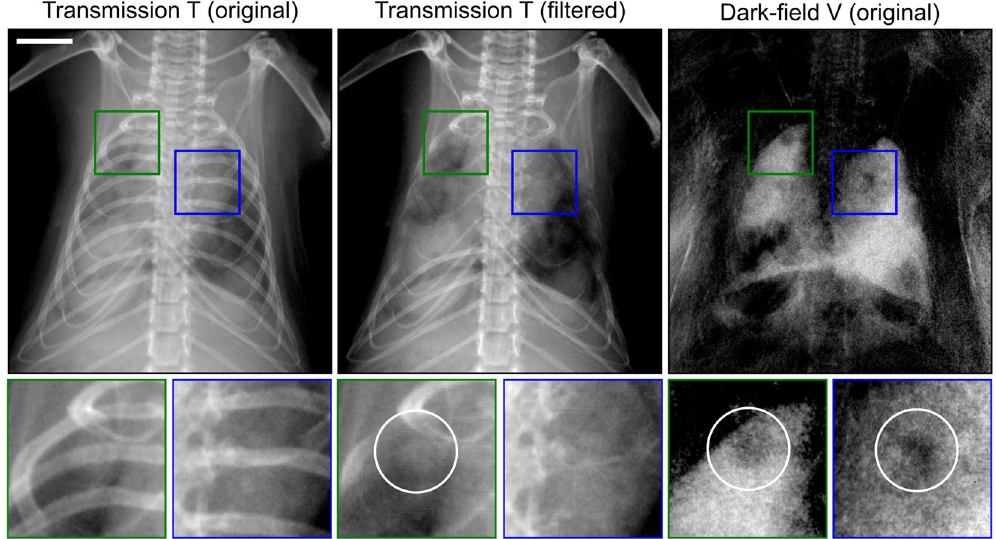
Figure 5. Outlook: initial comparison of ribcage-corrected transmission versus dark-field radiography and impact on tumor detection quality. In the left upper lung (green box) a small nodule is superimposed by multiple ribs and is visible only after ribcage removal, as indicated by a white circle in the filtered transmission radiogram. In case of a small lesion in the upper right (blue box), however, the tumor provides insufficient contrast with respect to healthy tissue, rather then being superimposed by bones. Consequently the suppression algorithm is not altering the detectability of the tumor. Note that both tumors are easily visible in the dark-field channel (white circles), contingent on a strongly enhanced sensitivity towards distortions in the micromorphological lung pattern caused by cancerous tissue. The scale bar corresponds to 5